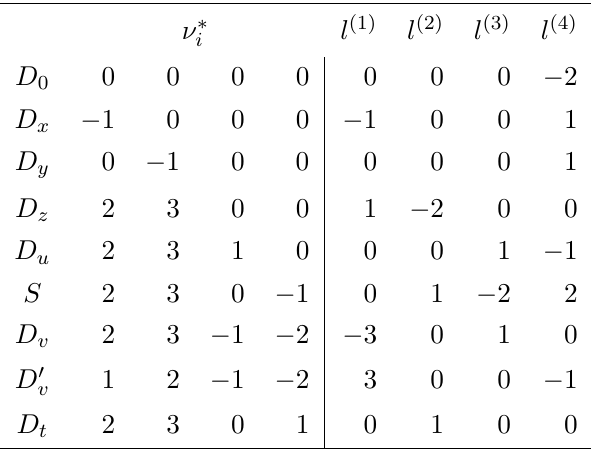
Table 2 . Toric divisors and Mori cone generators of the toric variety whose anti-canonical divisor is the compact embedding of massive M-string